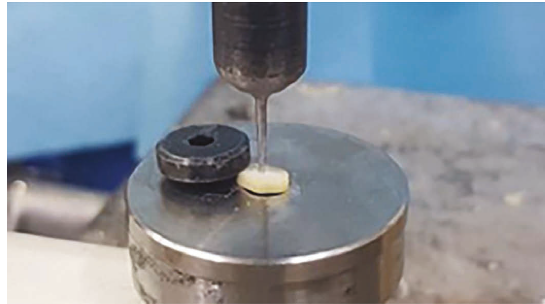
Figure 5: Push-out testing with a metal plunger.